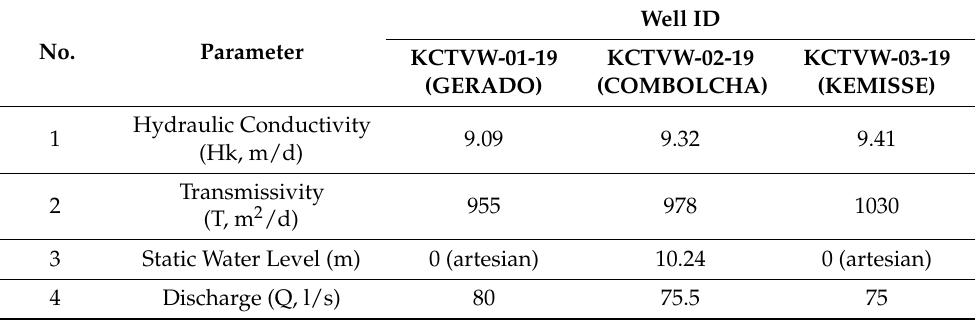
Table 7. Aquifer parameter values calculated using Aquifer Test software, from existing boreholes’ raw data (Source